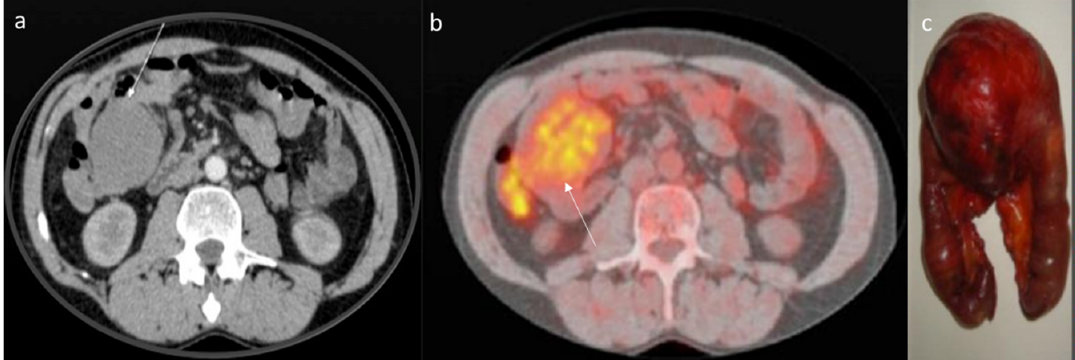
Figure 2. CT assessment (arrow) of mesenteric DT ( a ) in portal phase of contrast study. The lesion enhancement is mild to moderate. The 18-FDG ( b ) assessment (arrow) with moderate uptake. Surgical sample ( c ).